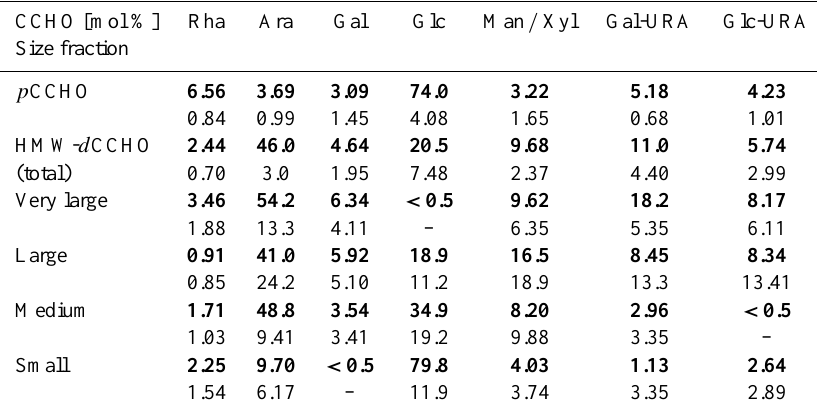
Table 3. Freshly produced combined carbohydrates (CCHO) in various size fractions. Average values (bold) and standard deviations (non- bold) in mol% CCHO are given for replicate samplings and both treatments, n = 6. Fuc, GalN and GlcN were always < 0 . 5mol% and are not included. CCHO [mol %] Rha Ara Gal Glc Man / Xyl Gal-URA Glc-URA Size fraction p